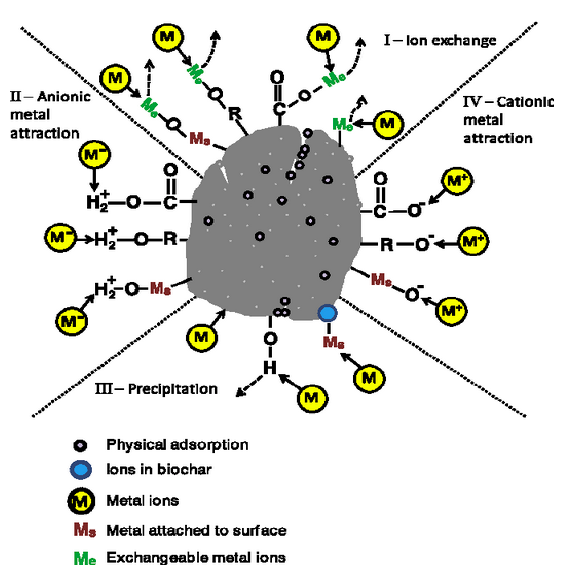
Figure 3. Types (mechanisms) of metal ion adsorption on the surface of carbonization products [124].